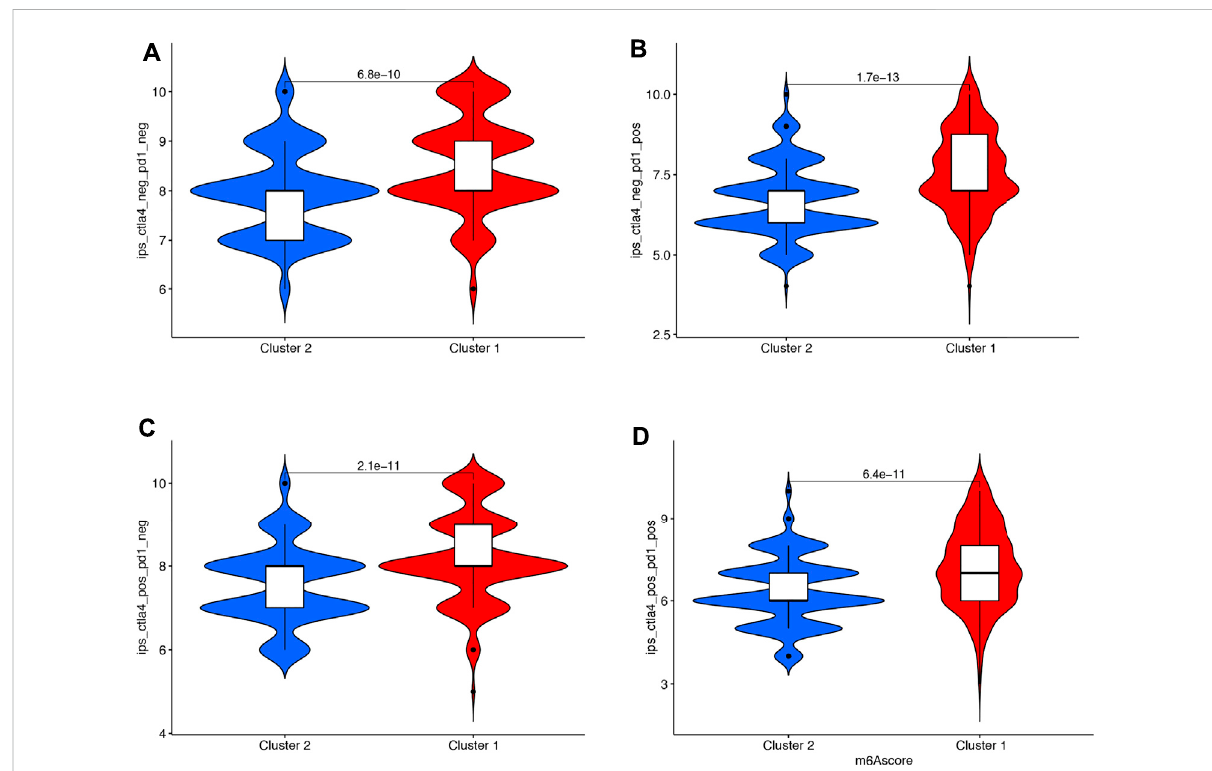
(Figure 8H) or in the cluster 2 (Figure 8I) subgroup had a high-risk score ( p < 0.05). Figure 9 reveals the correlation between risk score and immune cell in fi ltration. These data indicate a positive correlation between risk score and the in fi ltration levels of the macrophage M0 (cor = 0.32) and risk score increases, the abundance of regulatory T cells, follicular helper T cells, CD8 T cells, CD4 memory- activated T cells, and activated dendritic cells